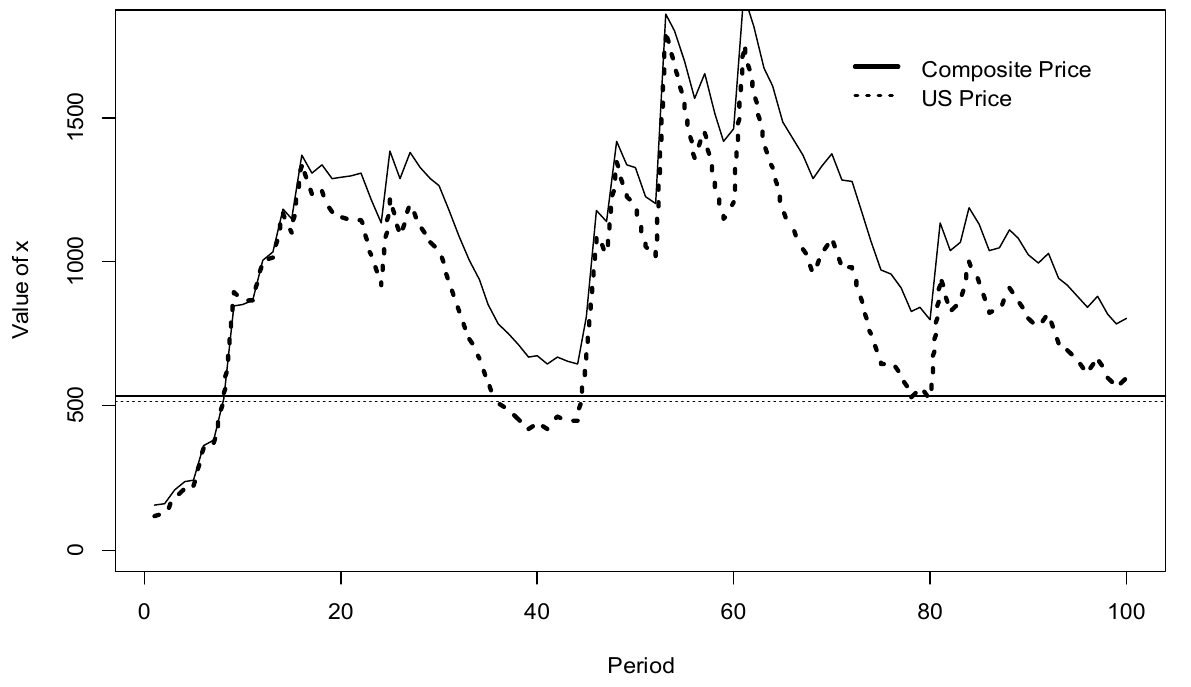
Figure 3. Potential paths of composite and U.S. lumber prices based on Ornstein–Uhlenbeck Stochastic Mean-Reversion processes with means indicated by straight lines.